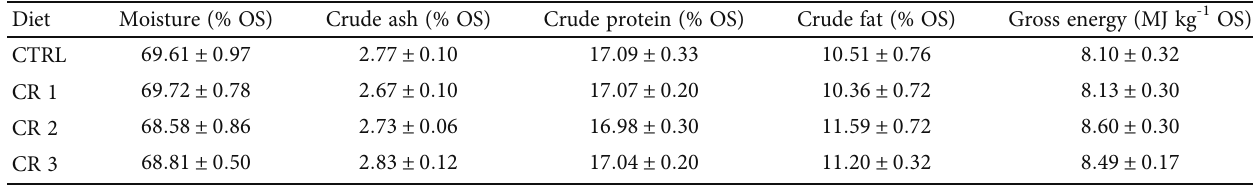
Figure 1: Regression analysis with speci fi c growth rate as dependent variable and organic chromium supplementation as the independent variable. Table 6: Proximate whole body composition of fi sh after 84 days of feeding ( mean ± SD